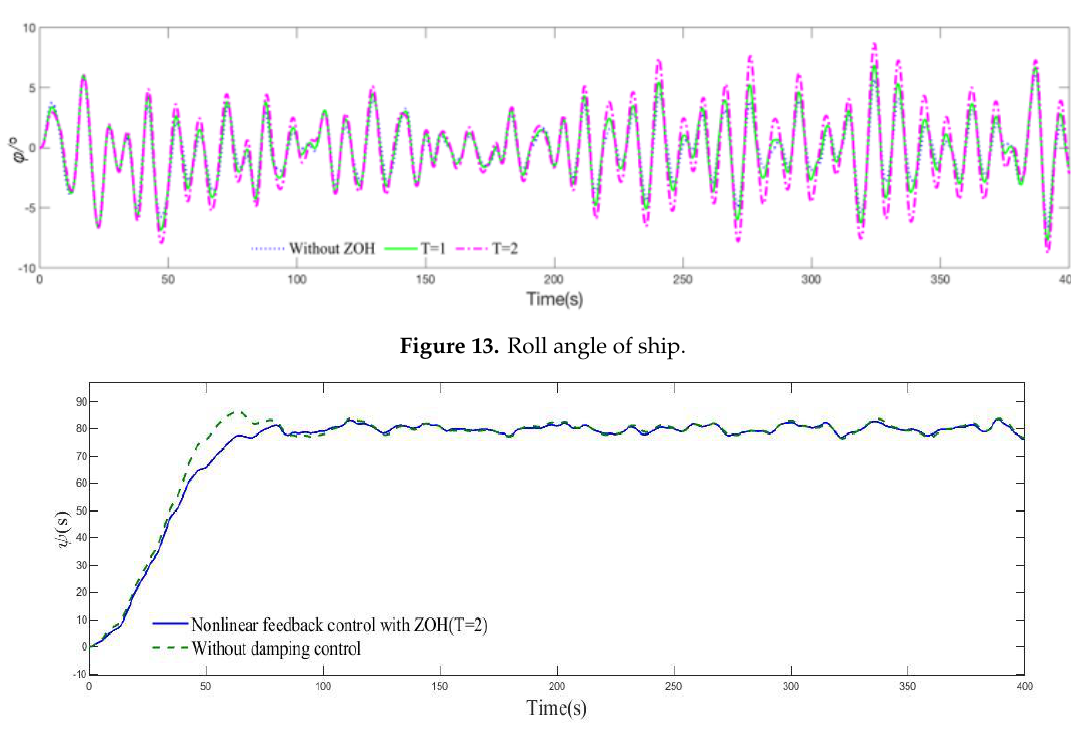
Figure 14. Course keeping when the hold time of ZOH is 2 s. Table 2. Influences of ZOH.